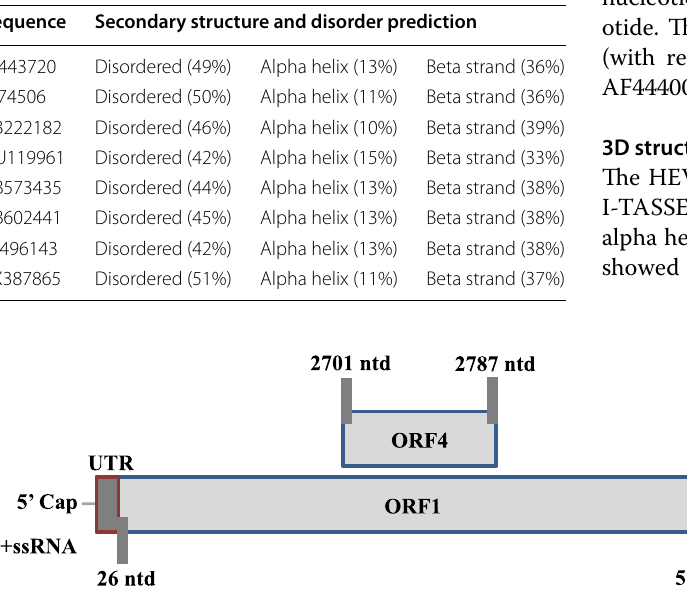
Table 1 Secondary structure and disorder prediction by Phyre2